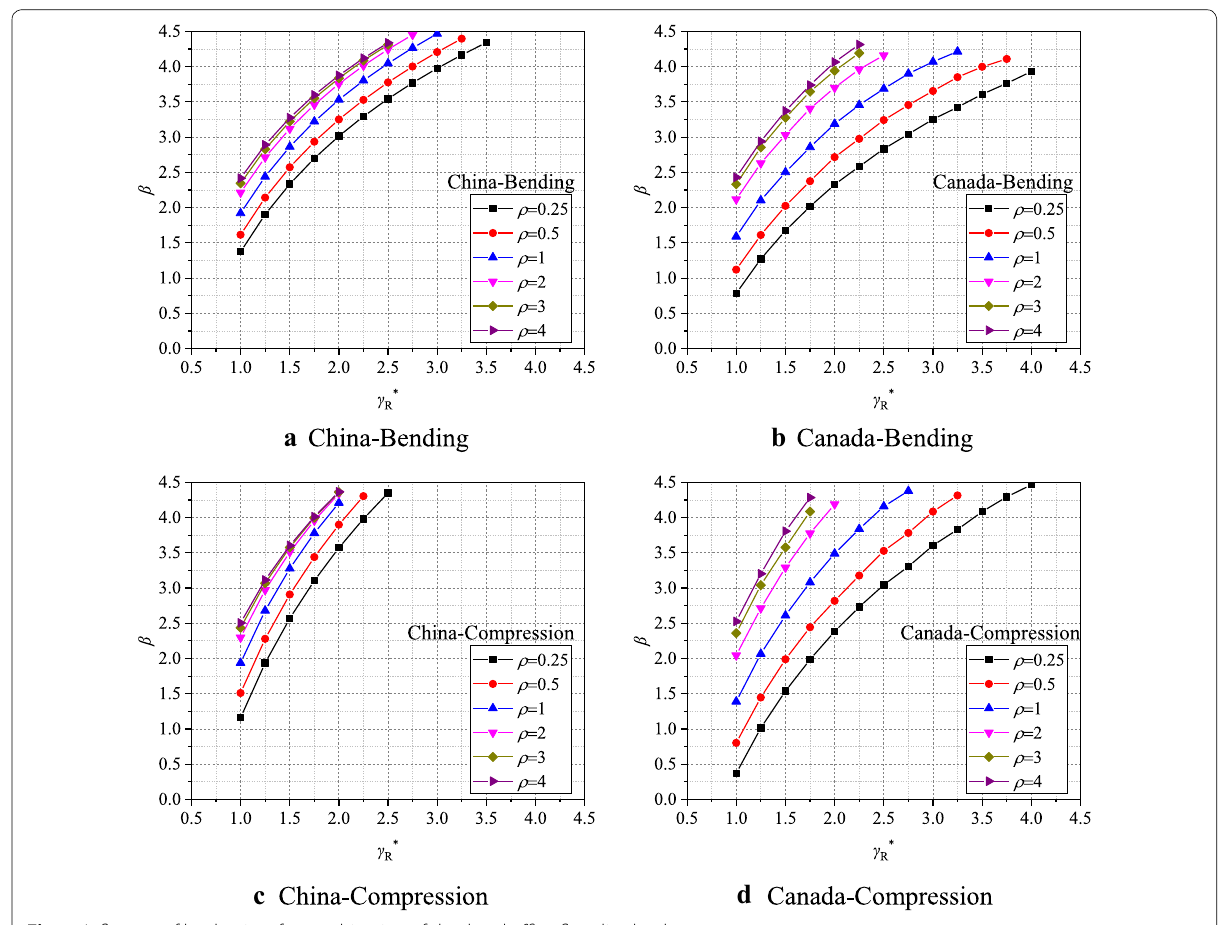
Fig. 4 Influence of load ratio ρ for combination of dead and office floor live